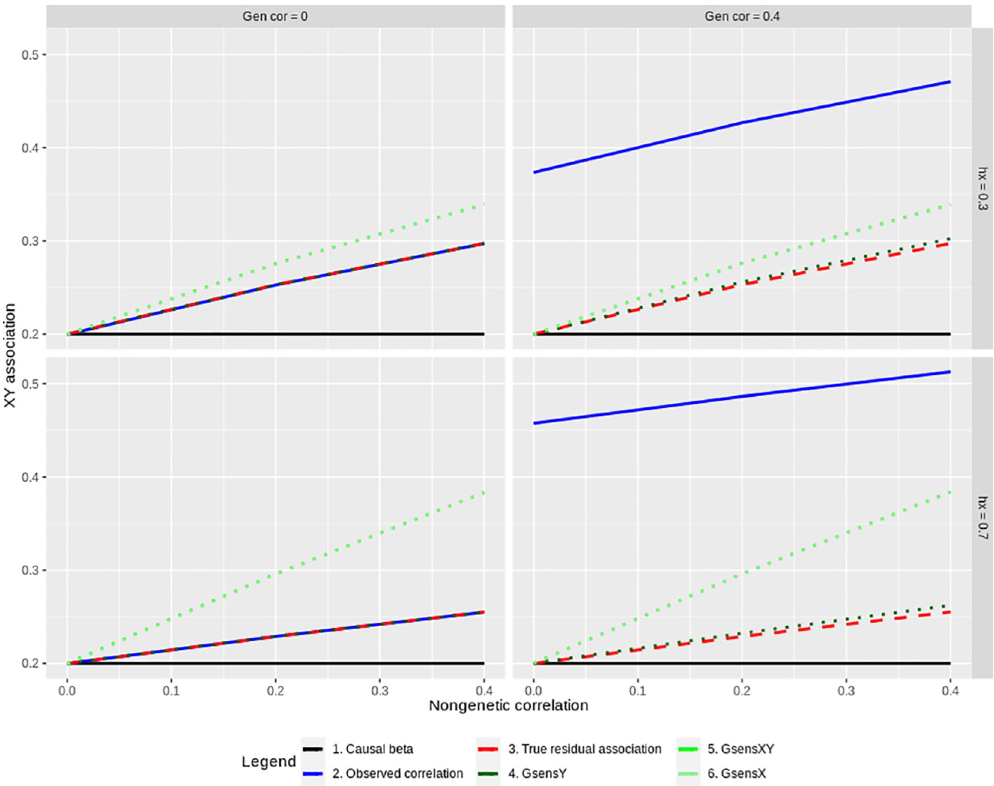
Fig 2. Collider bias: simulation results. The standardized association between X and Y (Y-axis) is plotted as a function of the correlation between the non-genetic factors for X and Y that generates non-genetic confounding (X-axis). The figure is faceted left to right according to the genetic correlation between direct effects that generates genetic confounding (gen cor), and top to bottom according to the heritability of X (hx). A subset of results is plotted with causal effect = 0.20, N = 10,000, heritability of Y = 70% and the full set of results is provided in S1 Data. Note that estimates from GsensX and GsensXY are very similar in this first set of simulations but can differ in the second when polygenic scores are set to capture varying levels of the heritability of X and